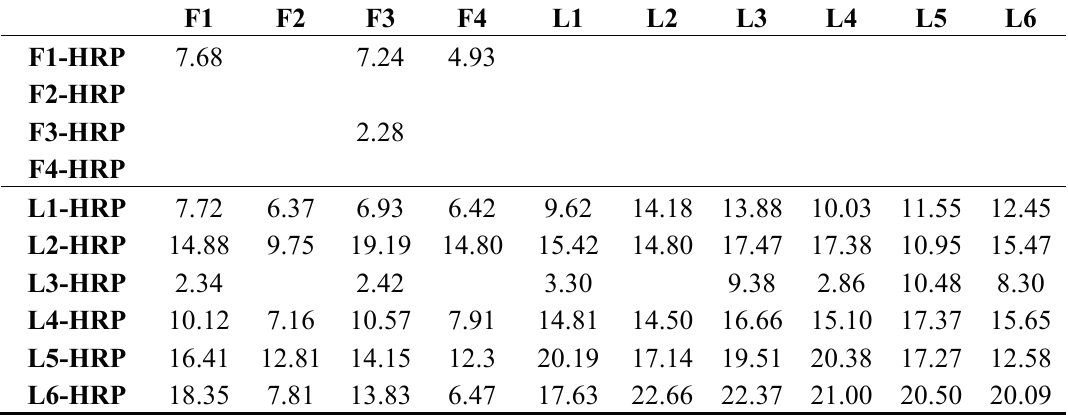
Table 2. Pairwise study of S. typhimurium flagellin MAbs and LPS MAbs in